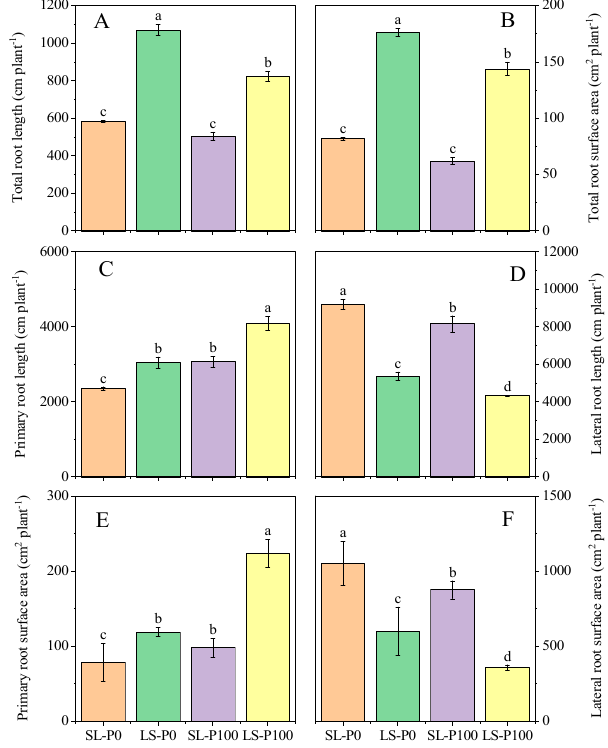
Figure 3. The effect of P application and light condition on ( A ) total root length, ( B ) total root surface at the V5 stage (Five trifoliolates unroll), the ( C ) primary root length, ( D ) lateral root length, ( E ) primary root surface, and ( F ) lateral root surface at the R3 stage (Pods are about 5 mm long on one of the four uppermost nodes on the main stem with a fully developed leaf) in the pot experiment. Plants were grown in two light conditions (SL: shade from sowing to the V5 stage and from V5 to R8 (95% of pods reach mature pod color) under natural light condition; LS: from sowing to the V5 stage under natural light condition and shade from V5 to R8) and two P application treatments (P0 = without P application; P100 = 100 mg P kg − 1 soil application). Values represent the mean of three replicates ± SE. Different letters on the columns are used to indicate means that differ significantly by LSD ( p ≤ 0.05).